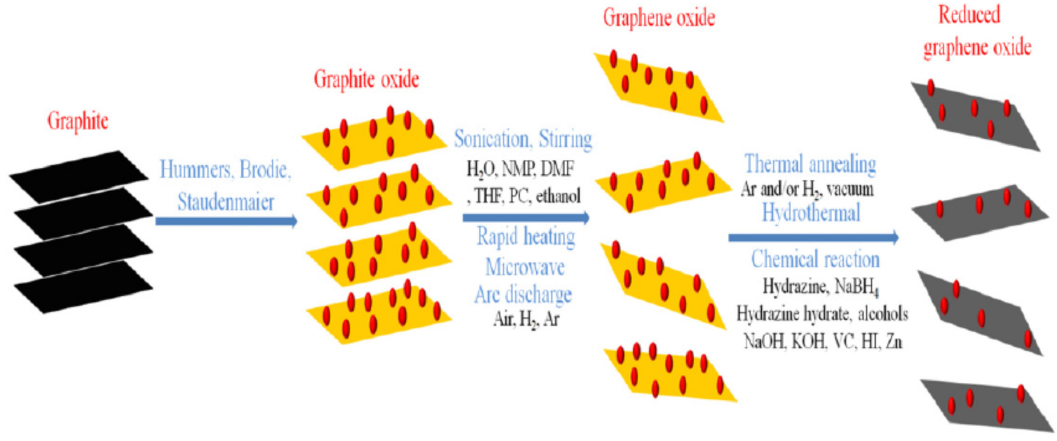
Figure 8. Synthesis of rGO from pristine graphite [84].